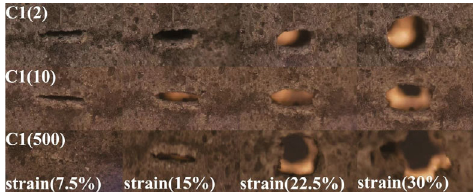
Figure 8: Microphotography (MP) results for group S (without precracking).